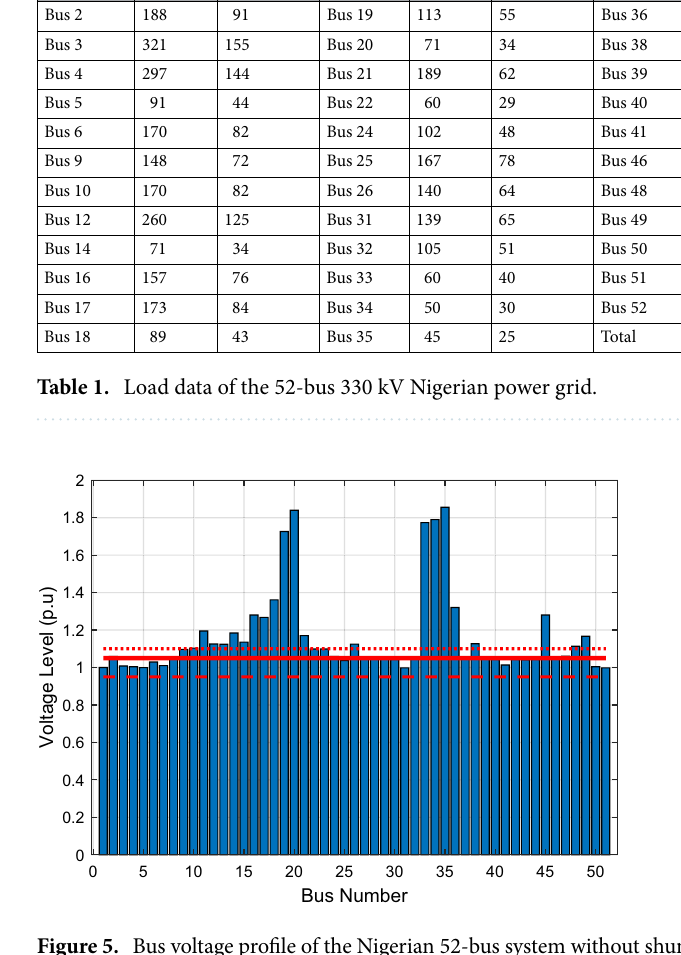
Figure 5. Bus voltage profile of the Nigerian 52-bus system without shunt